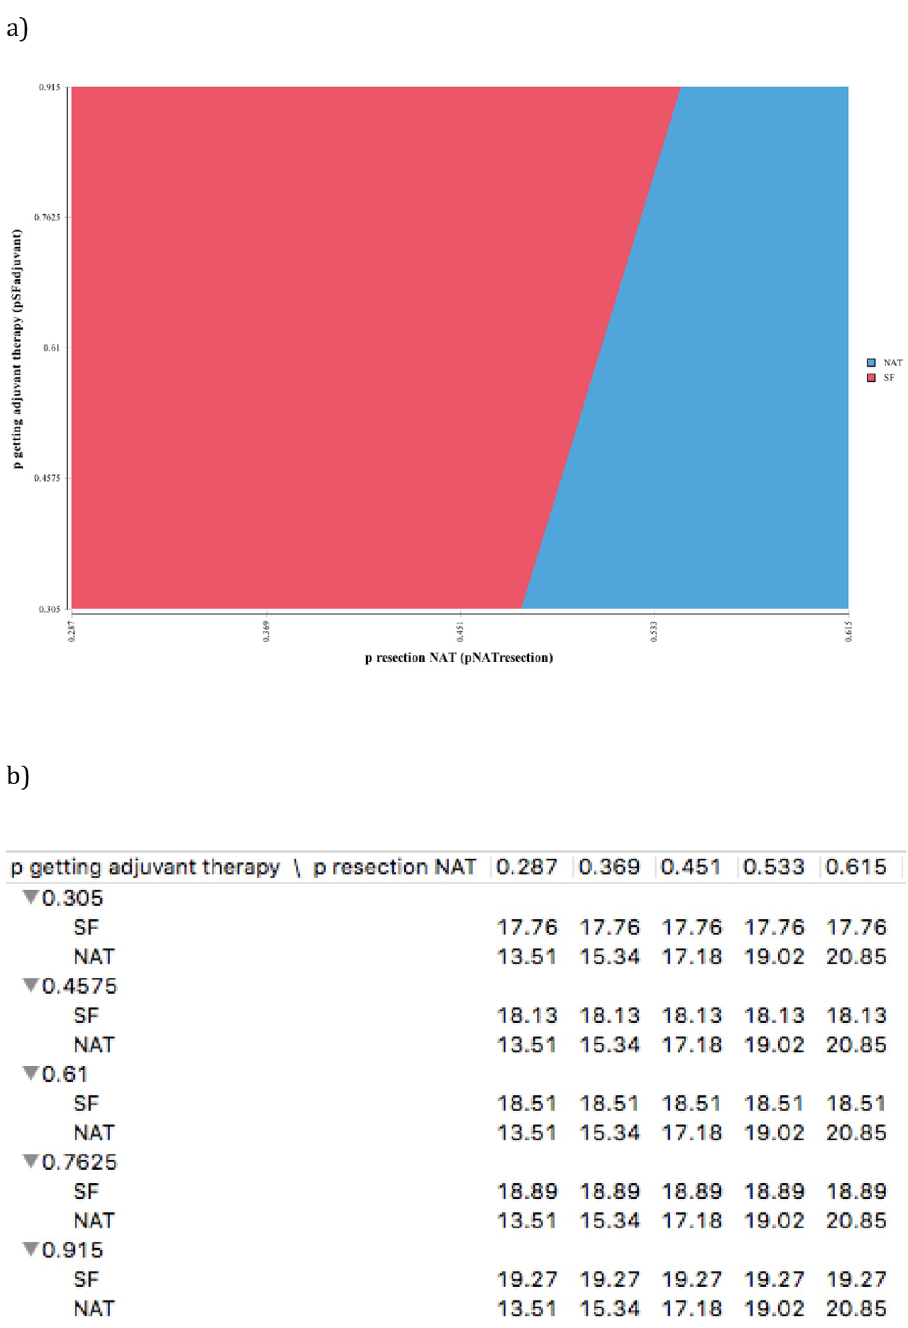
Fig 3. Two-way sensitivity analysis. Y-axis shows probability of receiving adjuvant therapy in SF pathway and x-axis shows probability of receiving resection in NAT pathway. The red area represents where patients, given competing probability of receiving multimodal treatment in competing pathways, would benefit from SF approach. The blue area represents where NAT would be the superior treatment option in terms of quality-adjusted survival. The corresponding predicted survival time in QALMs are detailed below. X and Y-axis provide altering probabilities of multimodal treatment in each pathway with corresponding survival time given in